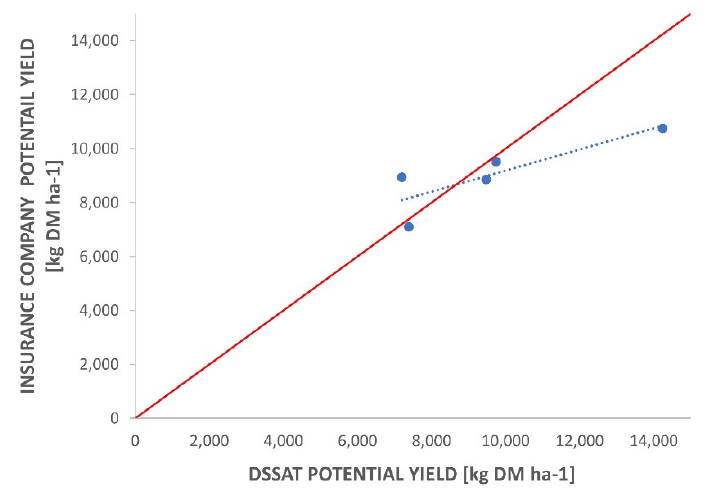
Figure 7. DSSAT-estimated potential yield (x axis) and potential yield estimates from the insurance agents (y axis) for the five damaged fields. Values are expressed as kg DM ha − 1 . The 1:1 line is reported in red.